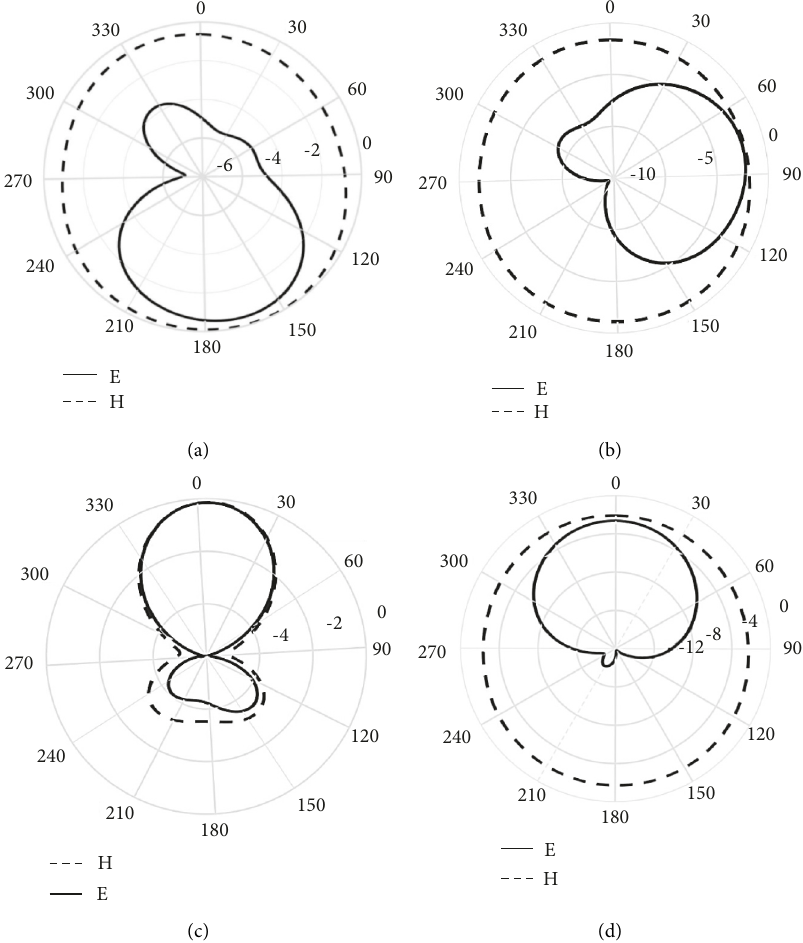
Figure 6: E-H plane for notch and in-band frequencies at (a) 5.1 GHz,(b) 5.5GHz, (c) 6.8GHz, and (d)